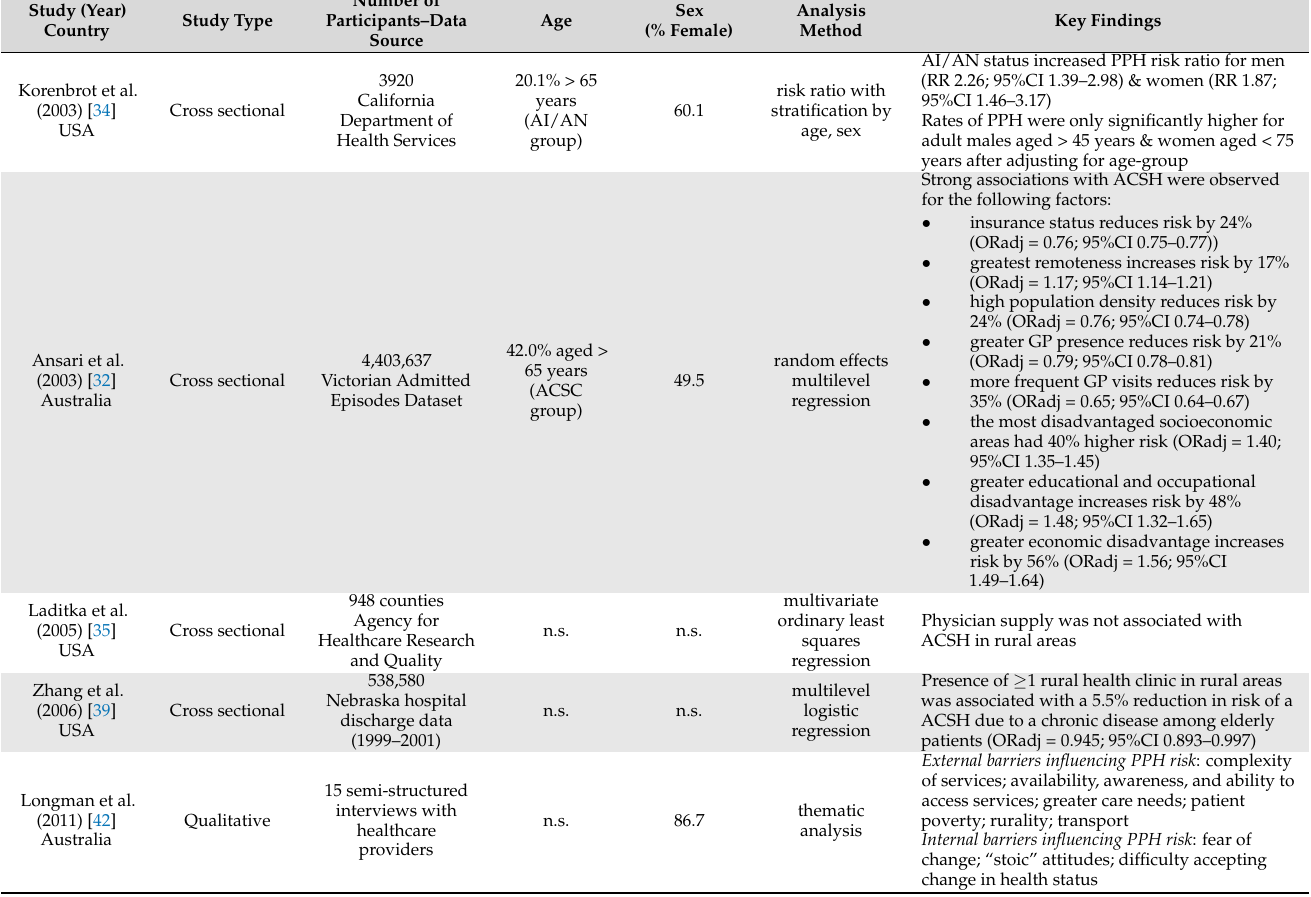
Table 2. Description of papers included in the